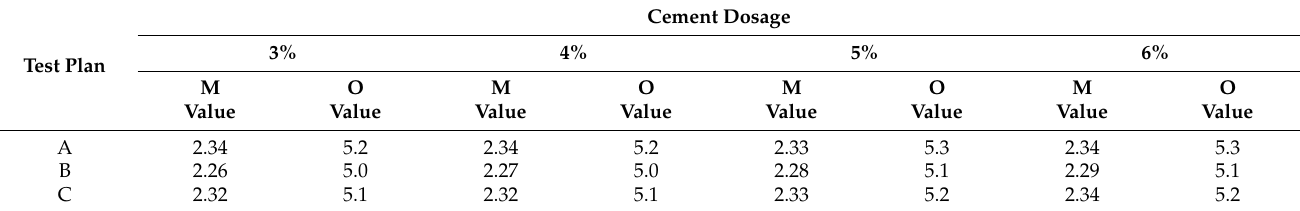
Table 8. Mix proportions of